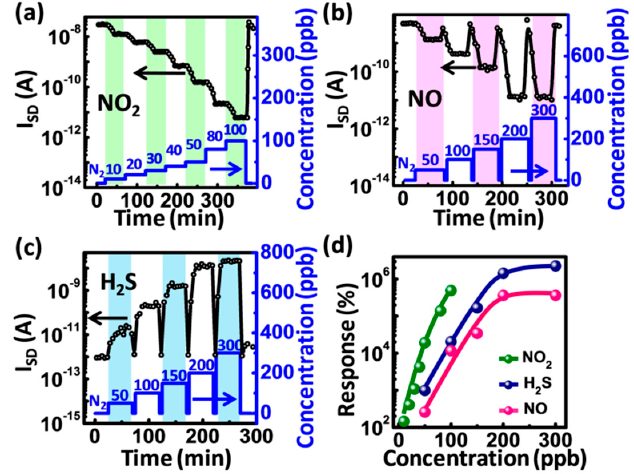
Figure 3. ( a – c ) real-time source-drain current ( I SD ) response to various concentrations of NO 2 , NO and H 2 S at room temperature. The blue line corresponds to the concentration of NO 2 , NO and H 2 S ( right : y -axis); and ( d ) the response of sensors to different analytes in dynamic concentrations.